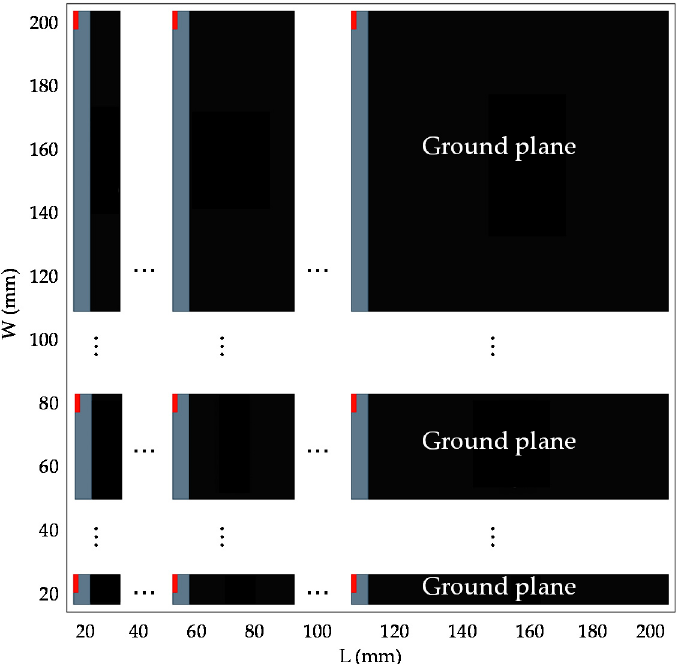
Figure 6. Different ground plane sizes are from the smallest (20 mm × 20 mm) to the biggest (200 mm × 200 mm). The simulation space includes 361 ground plane sizes. The antenna booster (12 mm × 3 mm × 2.4 mm) is shown in red. In all cases, the feeding line to feed the antenna booster was the same as well as the position of the antenna booster, as shown in Figure 1.